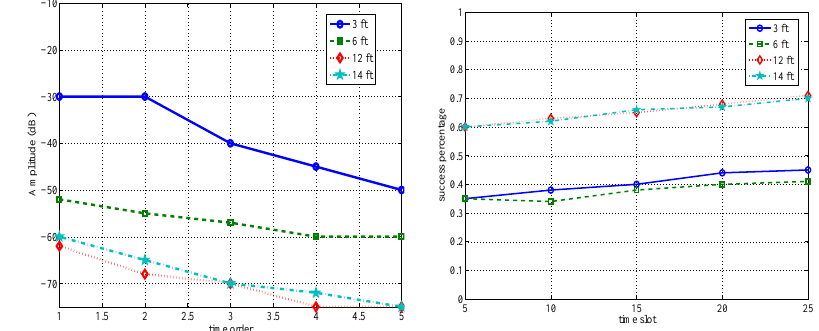
Figure 12. The multi-hop topology. Figure 13. Sensing results. Figure 14. Results for four